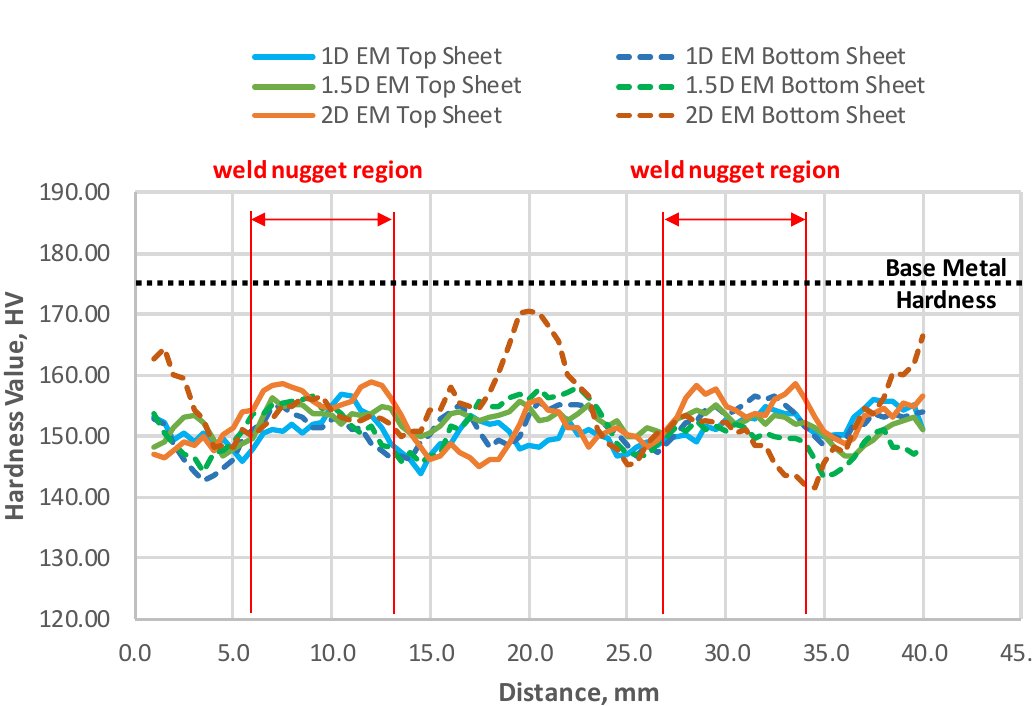
Figure 17. Microhardness values of the 3D-pitch cross-section specimens. Notes: D = 7 mm (Spot Weld Diameter); pitch = Spot Weld Spacing; EM = Edge Margin.